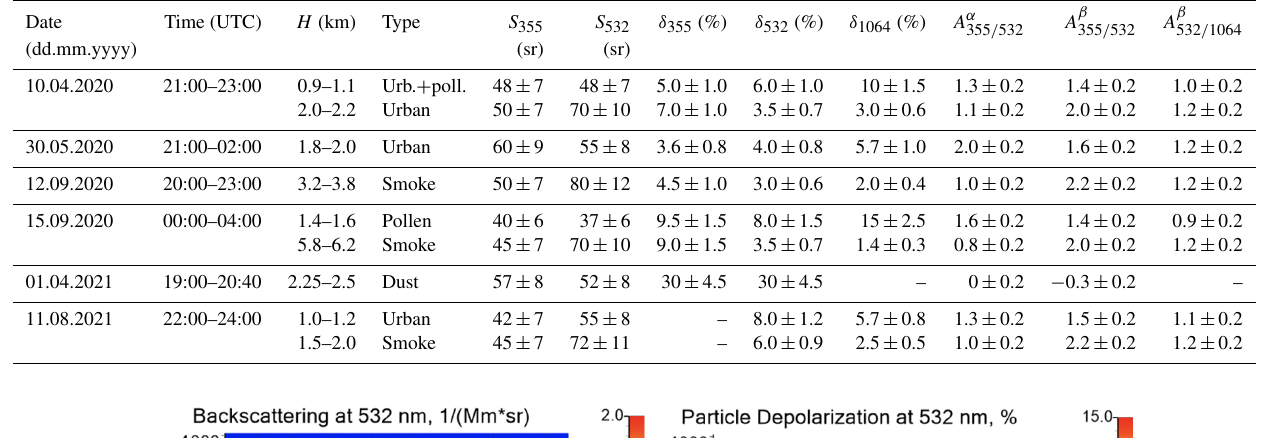
Table 2. Intensive particle parameters, such as the lidar ratios ( S 355 , S 532 ), particle depolarization ratios ( δ 355 , δ 532 , δ 1064 ), extinction ( A α ), and backscattering ( A β , A β ) Ångström exponents for six episodes are analyzed in this work. The parameters are 355 / 532 355 / 532 532 / 1064 given for chosen height–temporal intervals, and the types of aerosol are determined from fluorescence measurements.